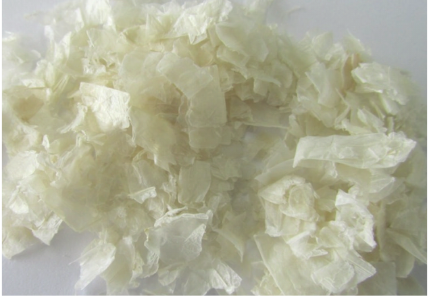
Figure 5: Chitosan flakes obtained from biologically purified